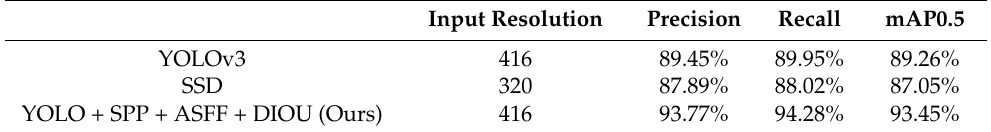
Table 1. Results for improved ship